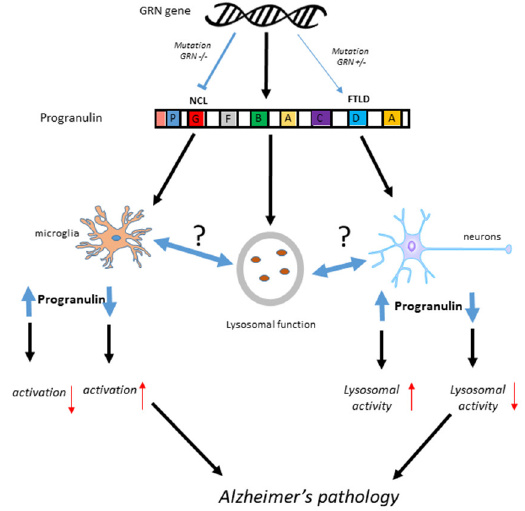
Figure 1. Summary of possible PGRN mechanisms in Alzheimer’s disease, FTLD and NCL. It is hypothesized that loss of PGRN, not increased expression that contribute to Alzheimer’s pathology.